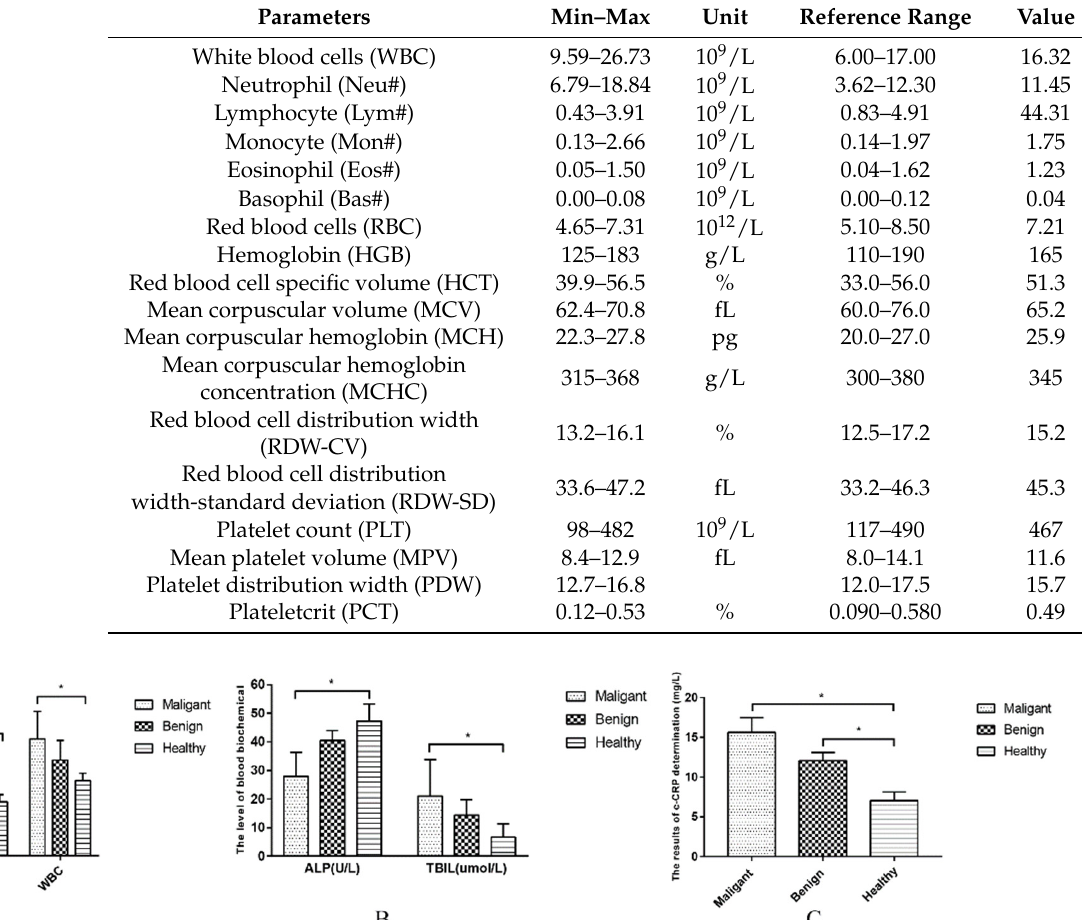
Figure 3. Comparison of blood examination results in each group. ( A ) Comparison of Lym#, Neu# and WBC levels in each group; ( B ) Comparison of ALP and TBIL levels in each group; ( C ) Compar- ison of CRP levels in each group. Note: Highly significant ( p < 0.05) as indicated by *. Table 2. Results of routine blood tests.